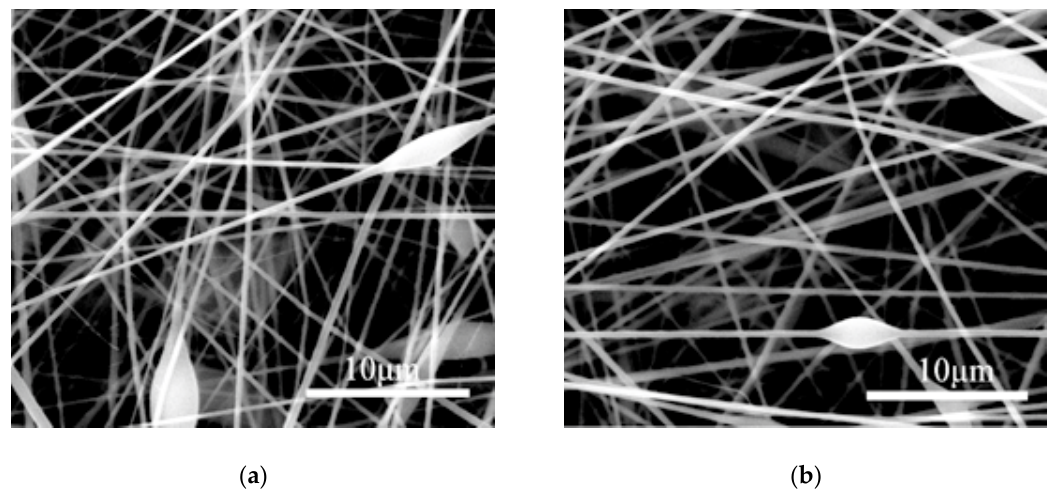
Figure 1. Bead-like structures at different voltages and PAN mass fraction of 12%. ( a ) Environmental scanning electron microscope (ESEM) image of bead-like structures at 10 kV; ( b ) ESEM image of bead-like structures at 11 kV. Scale bars: (a,b) 10 μ m.